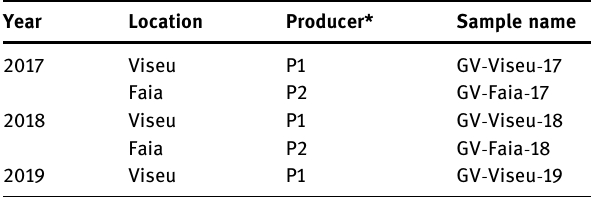
Table 1: Location of the di ff erent samples used in the